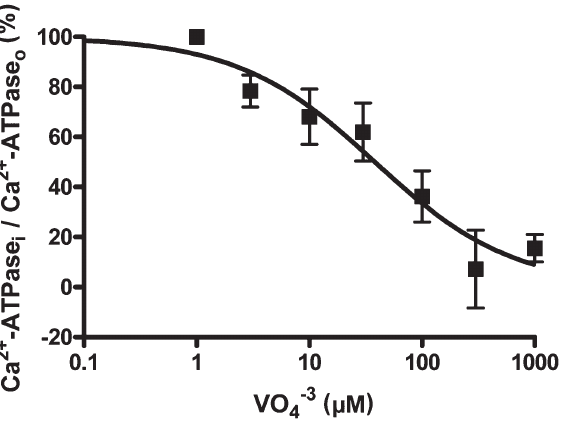
Figure 2. Inhibition of thapsigargin-sensitive Ca 2 + -ATPase activity by vanadate. The assays were performed in triplicate with 10 m M Ca 2 + and the results are reported as means ± SE for 4 experiments, using 3 different preparations. Ca 2 + -ATPase activity was measured without vanadate in the control. The smooth curve was fitted to the data points using Equation 2 as described in the text. Ordinate legend: Ca 2 + -ATPase i and Ca 2 + - ATPase o represent activity in the presence and in the absence of vanadate at each concentration of the inhibitor, respectively.